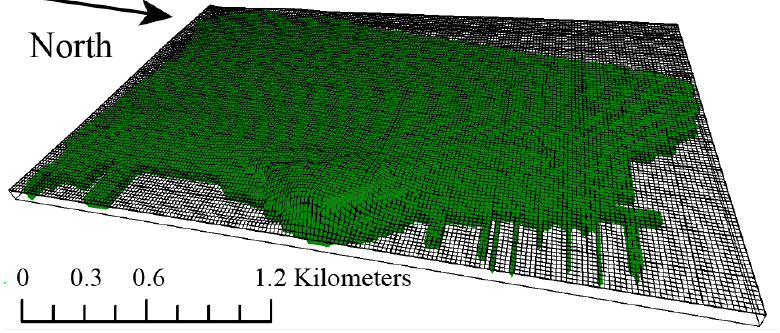
Figure 7. Domain of the aquifer of the City of Hoboken as implemented in MODFLOW